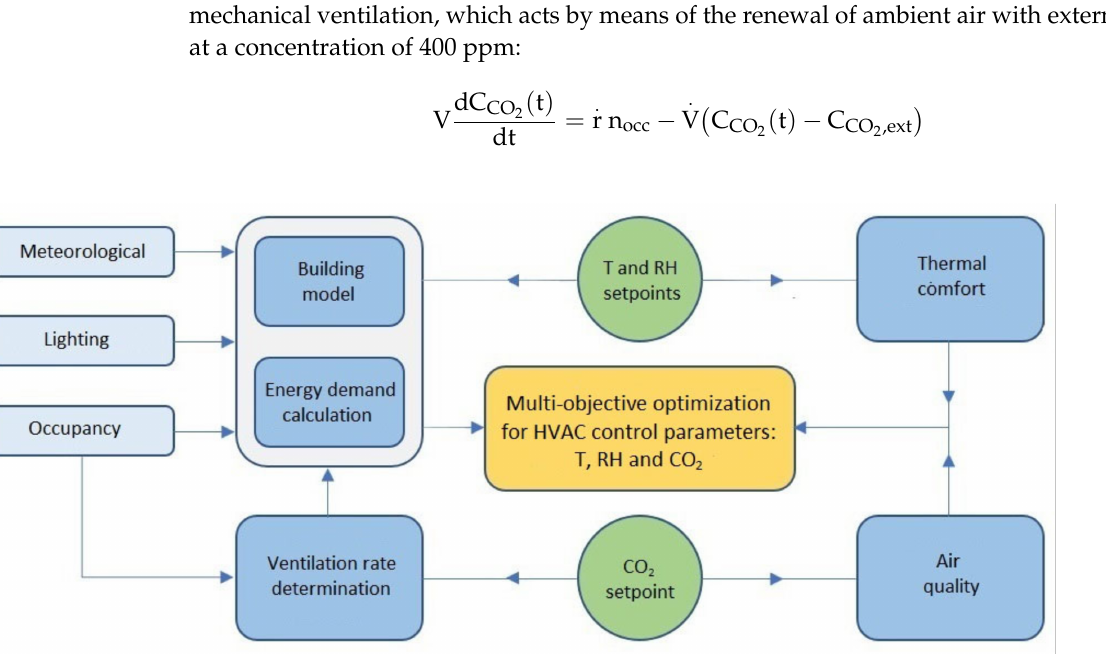
Figure 3. Multi-objective optimization: overall methodological